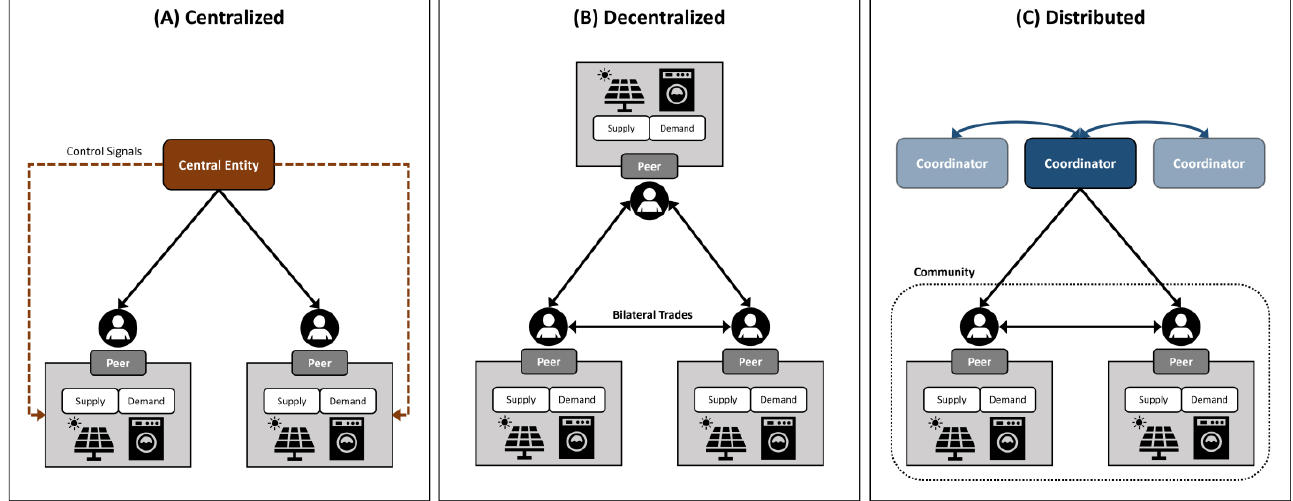
Figure 4. Diagrams of market designs for P2P energy trading: ( A ) Centralized; ( B ) Decentralized; ( C ) Distributed.